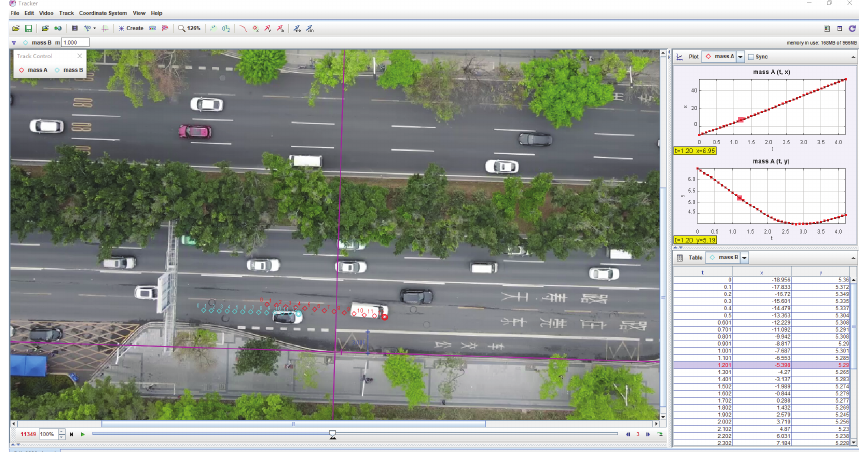
Figure 5: Schematic diagram of extracting lane-change conflicts.